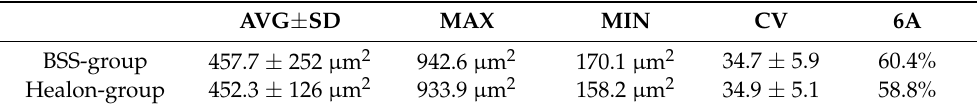
Table 1. Preoperative endothelial cell area pattern and shape.